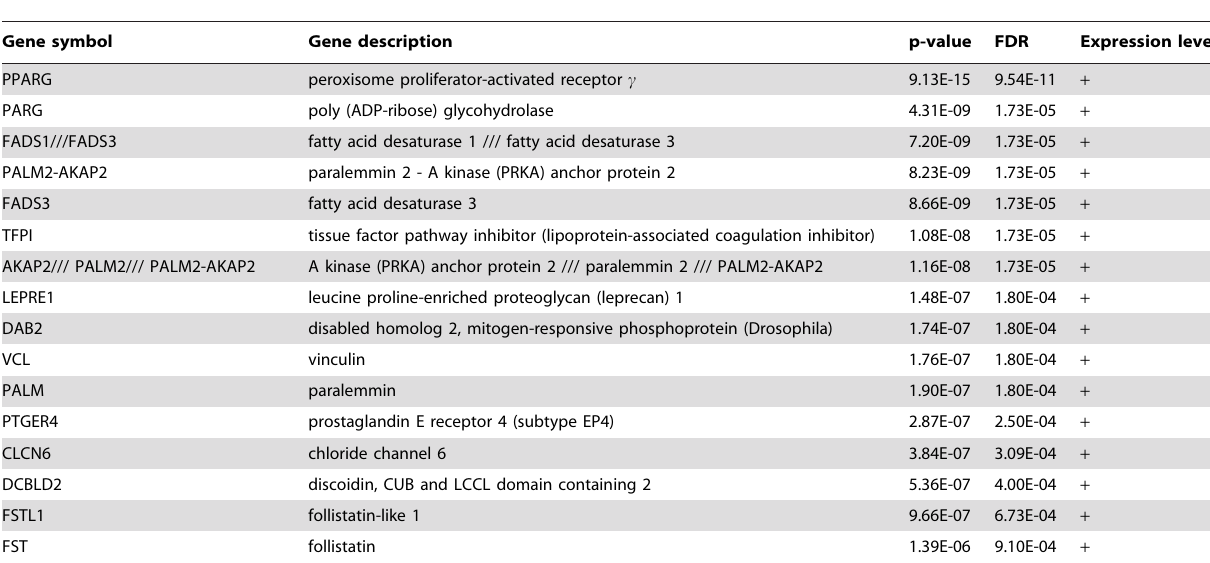
Table 1. Best genes for predicting the stellate cluster based on moderated t-statistic ( FDR v 0 : 001 ).